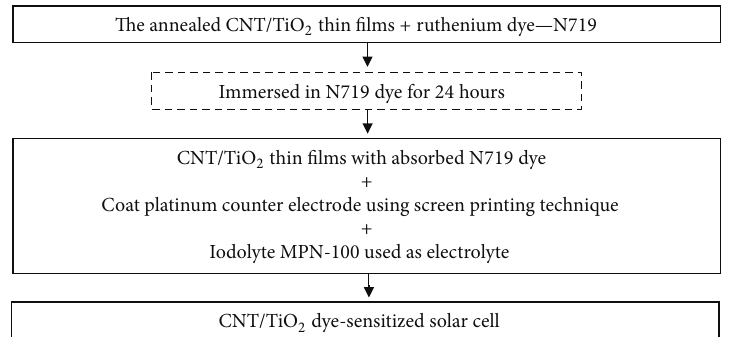
Figure 3: Flowchart for CNT/TiO 2 dye-sensitized solar cell fabrication.